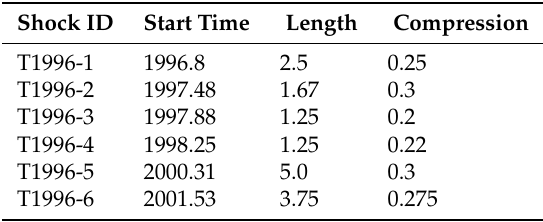
Table A2. Shock attributes for T1996.